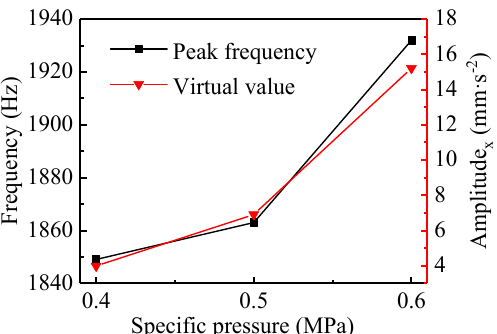
Figure 7. Displacement and frequency spectrum of N-502 under different specific pressures with the μ 1 friction coefficient.